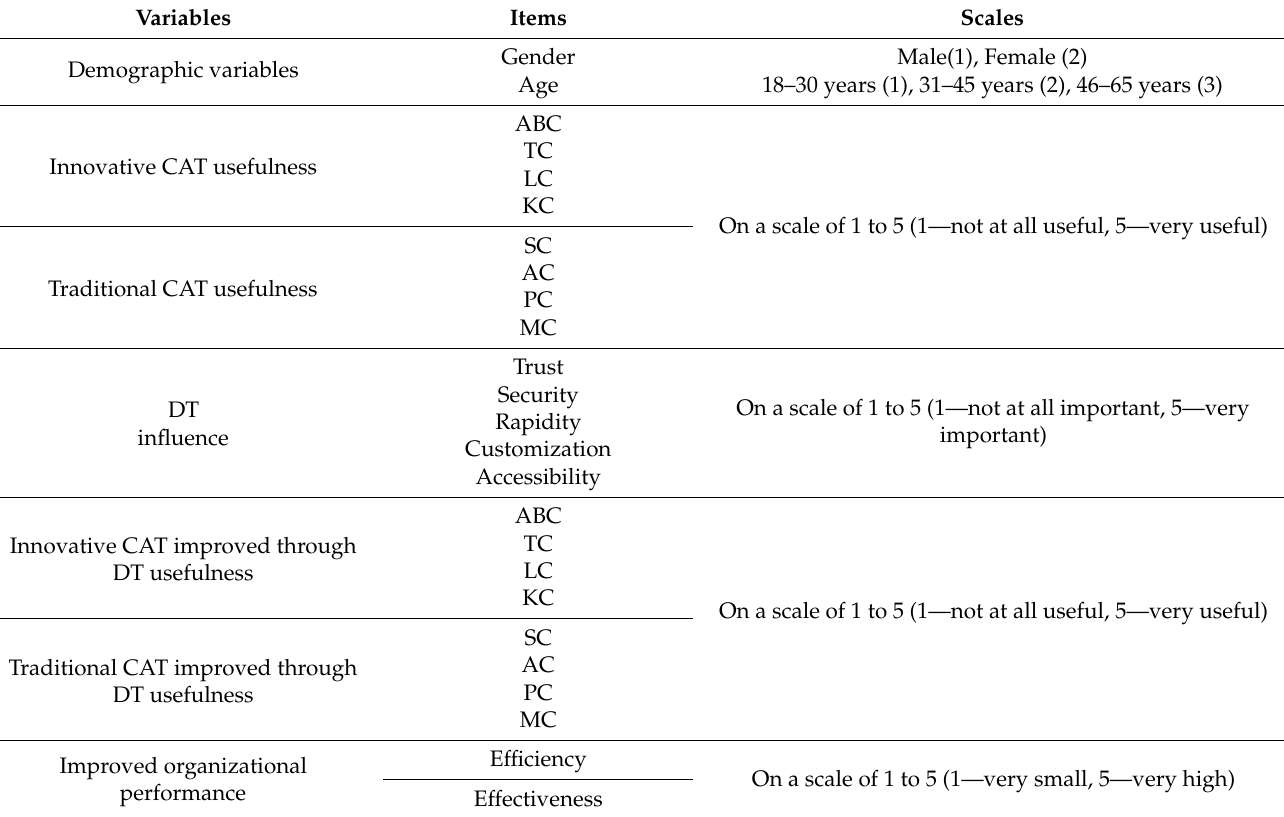
Table 3. Questionnaire structure and